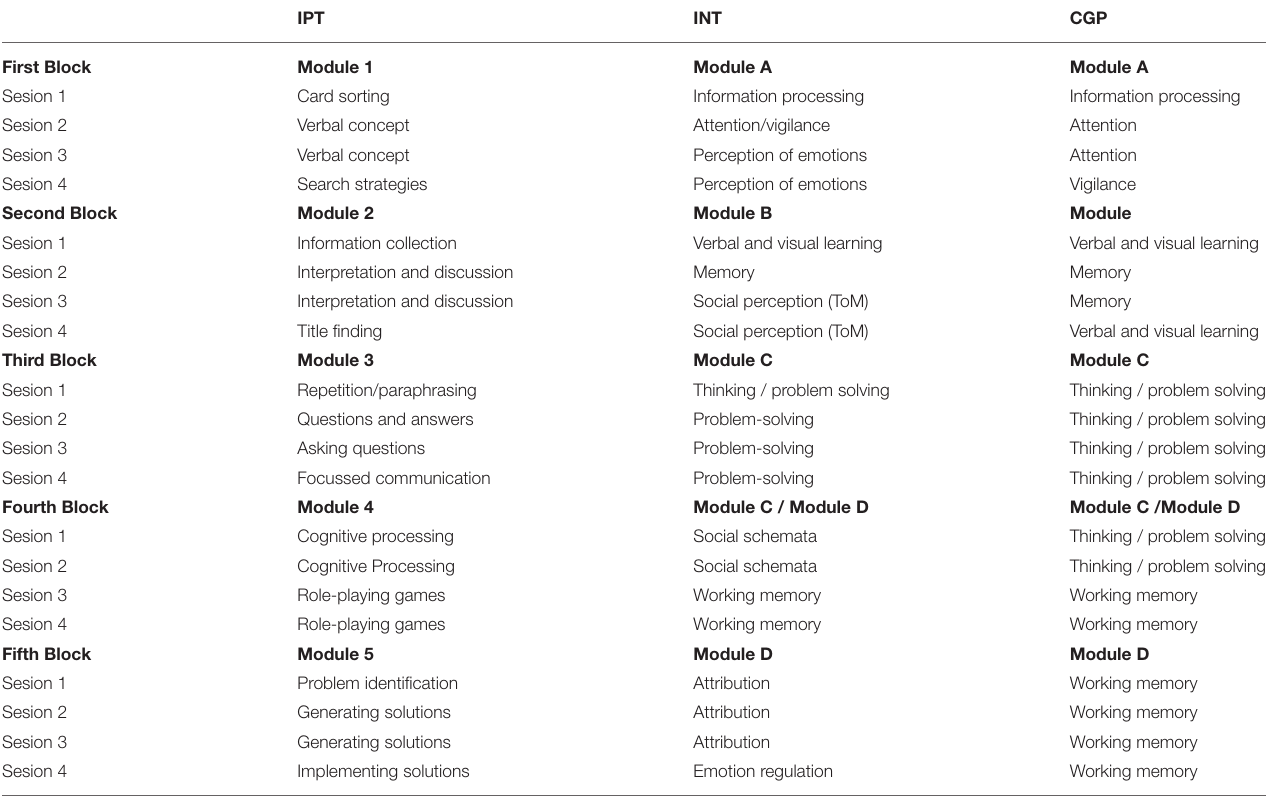
TABLE 2 | Content and chedule of Interventions (ToM: Theory of